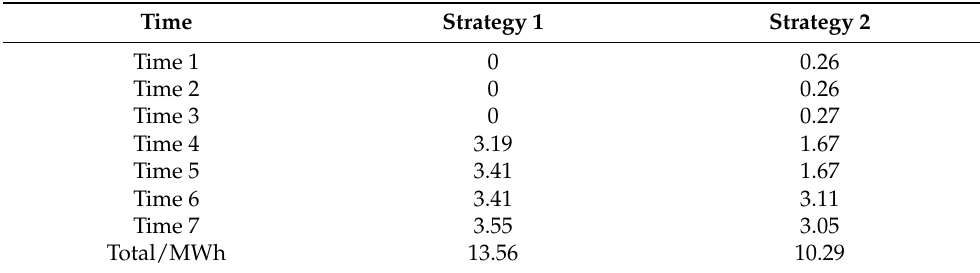
Table 2. Comparison of system load shedding amount under two dispatch strategies. Time Strategy 1 Strategy